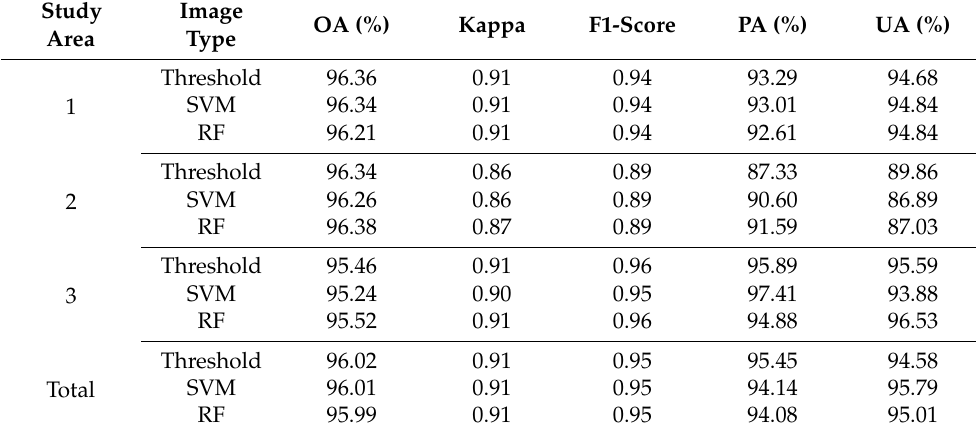
Table 6. Classification accuracy of CFI images by using the decision tree model, SVM and